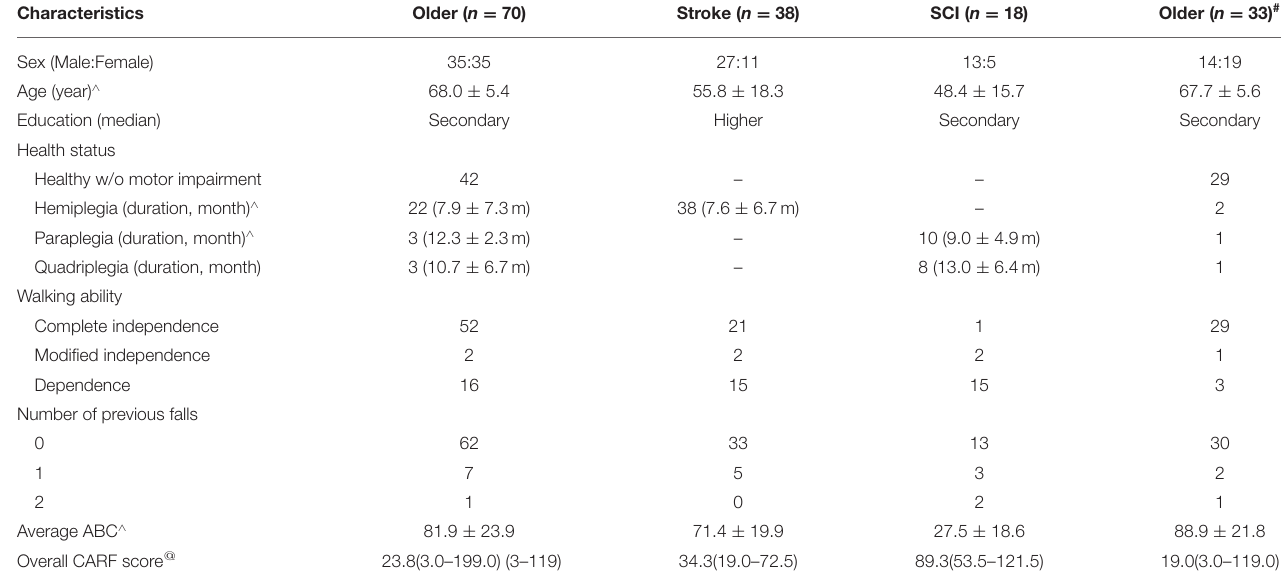
TABLE 1 | Participant characteristics.